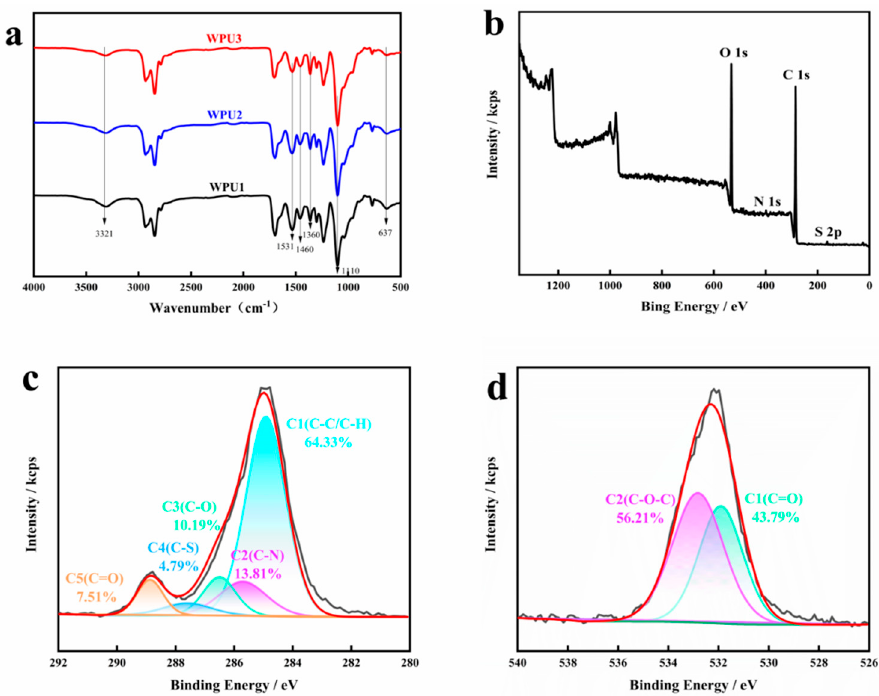
Figure 3. ( a ) FTIR spectra of WPU-SS samples, ( b ) XPS survey spectra of WPU2, ( c ) C 1s of WPU2, and ( d ) O 1s of WPU2.